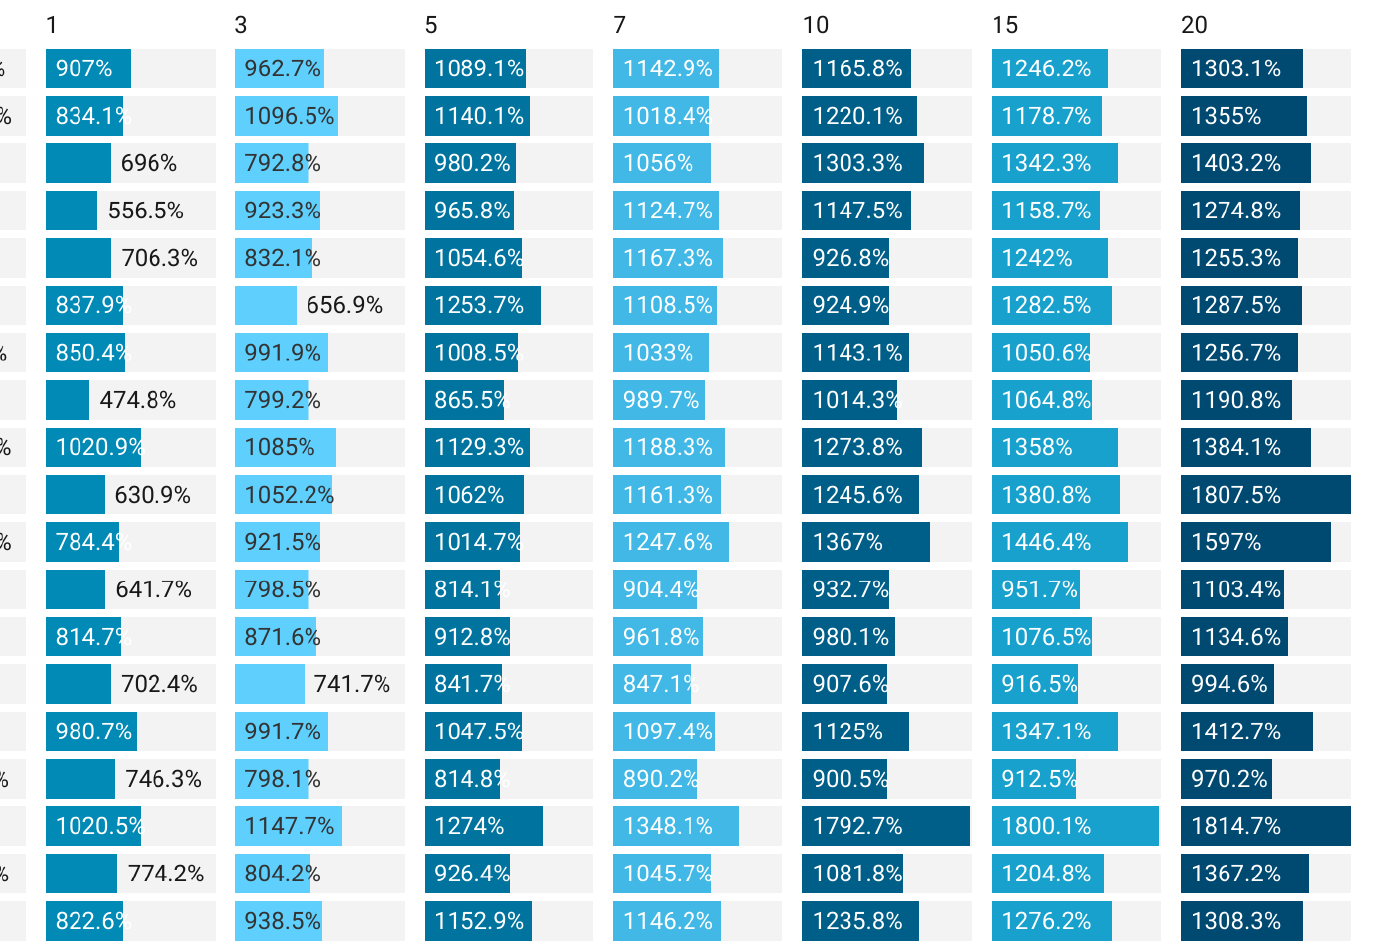
Figure 2. Swelling ratio index of films developed with EO included. B1-B19 sample designation, 0.5 – 20 represents the time, in minutes, of maintaining the sample in the liquid.